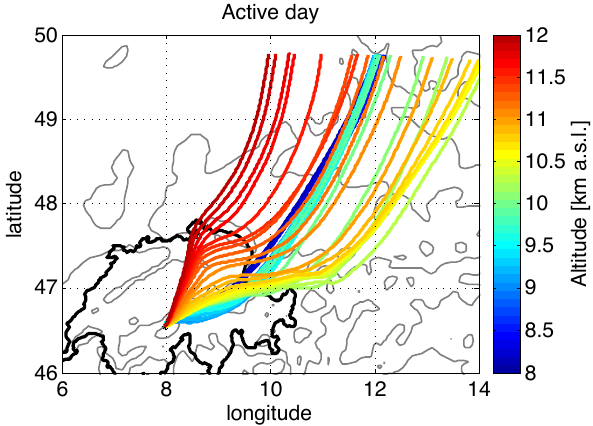
Figure A3. Power spectral density of the temperature calculated for trajectories arriving above Jungfraujoch as compared to the SUC- CESS and MACPEX campaigns. Green line: PSD for quiet case on 22 November 2011 (identical to Fig. 3). Purple line: active case on 12 March 2012 discussed in the Appendix.